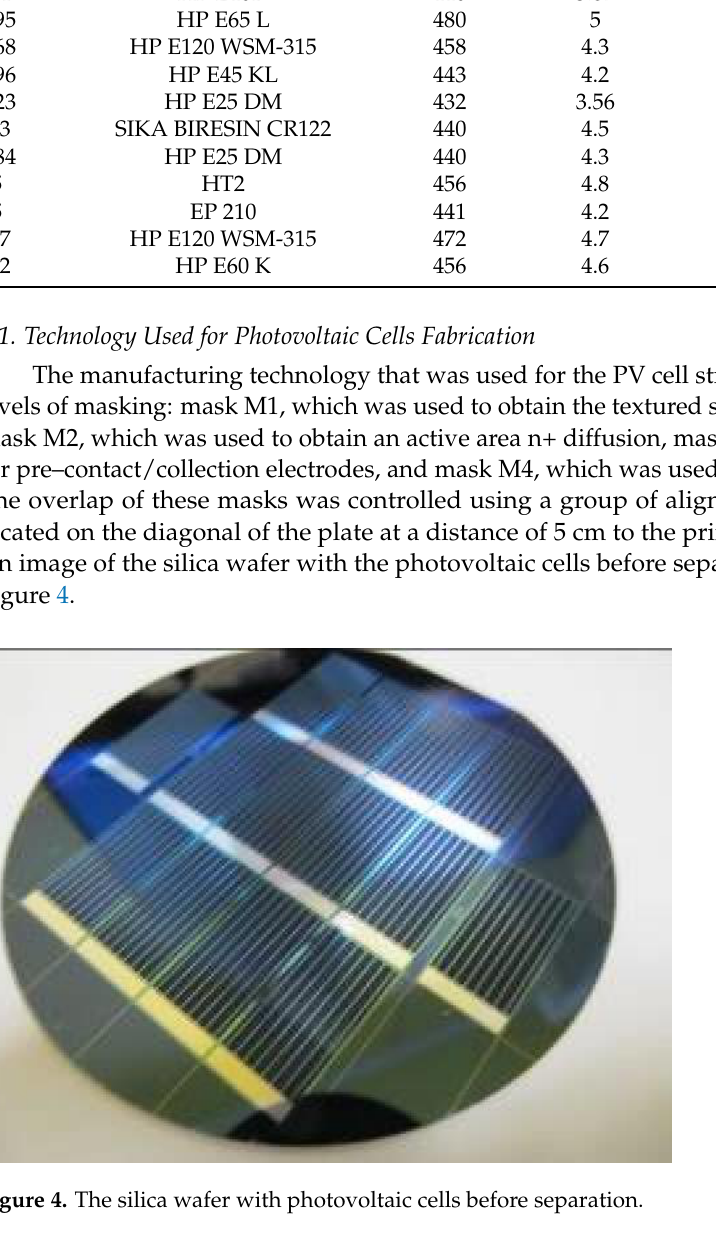
Figure 4. The silica wafer with photovoltaic cells before separation.